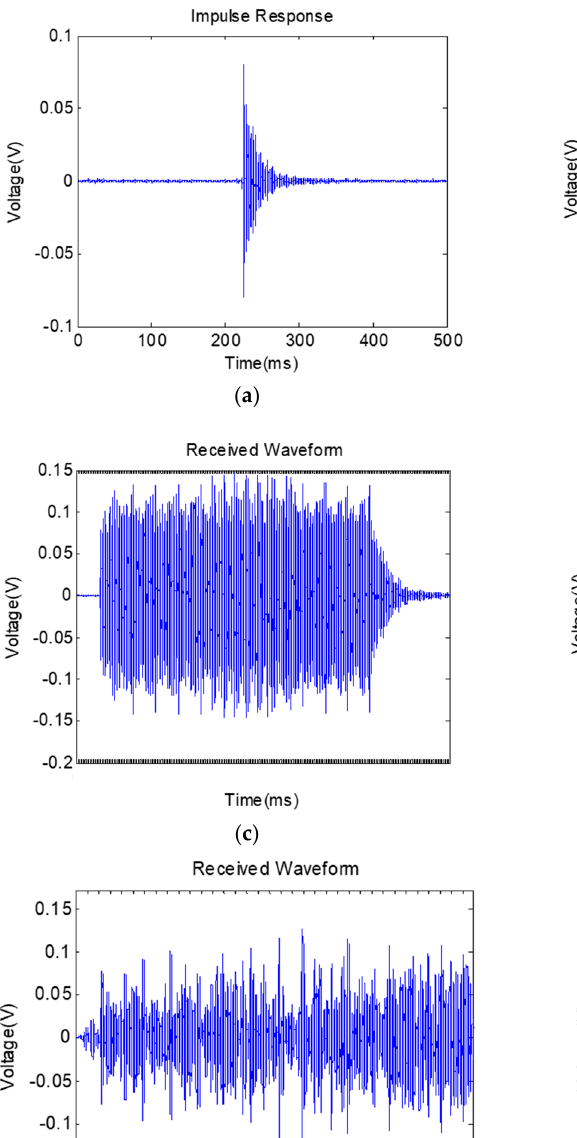
Figure 13. Experimental setup.